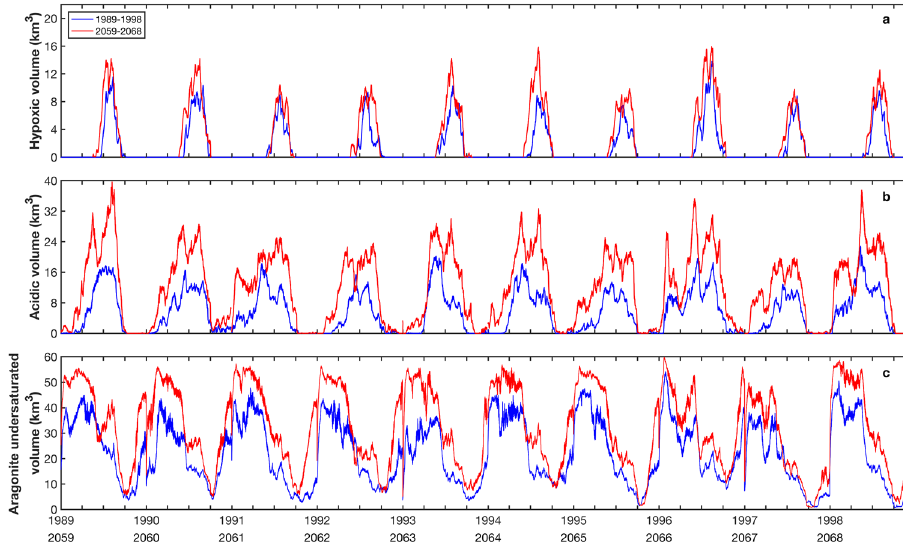
Fig. 2 Projected changes in the hypoxic and acidic volumes in Chesapeake Bay. Time series of the hypoxic (O 2 ≤ 2 mg/L) volume ( a ), the acidic (pH T ≤ 7.5) volume ( b ), and the aragonite under-saturated ( Ω arag (cid:3) 1) volume ( c ) during the late 20th (blue) and mid-21st century (red). COMMUNICATIONS EARTH & ENVIRONMENT| (2023) 4:68